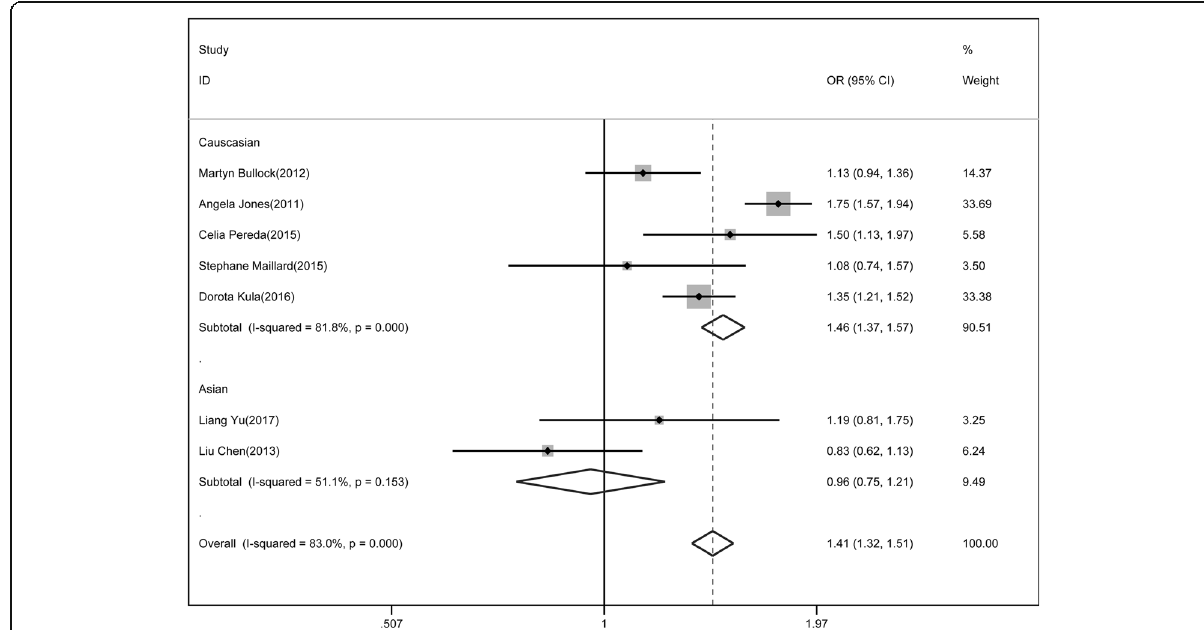
Fig. 4 Association of rs1867277 polymorphism with differentiated thyroid cancer